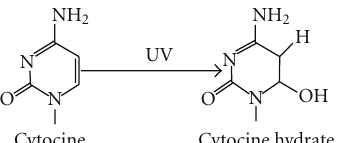
Figure 5: Formation of cytosine photohydrate (6-hydroxy-5,6- dihydrocytosine) as a result of photohydration reaction.